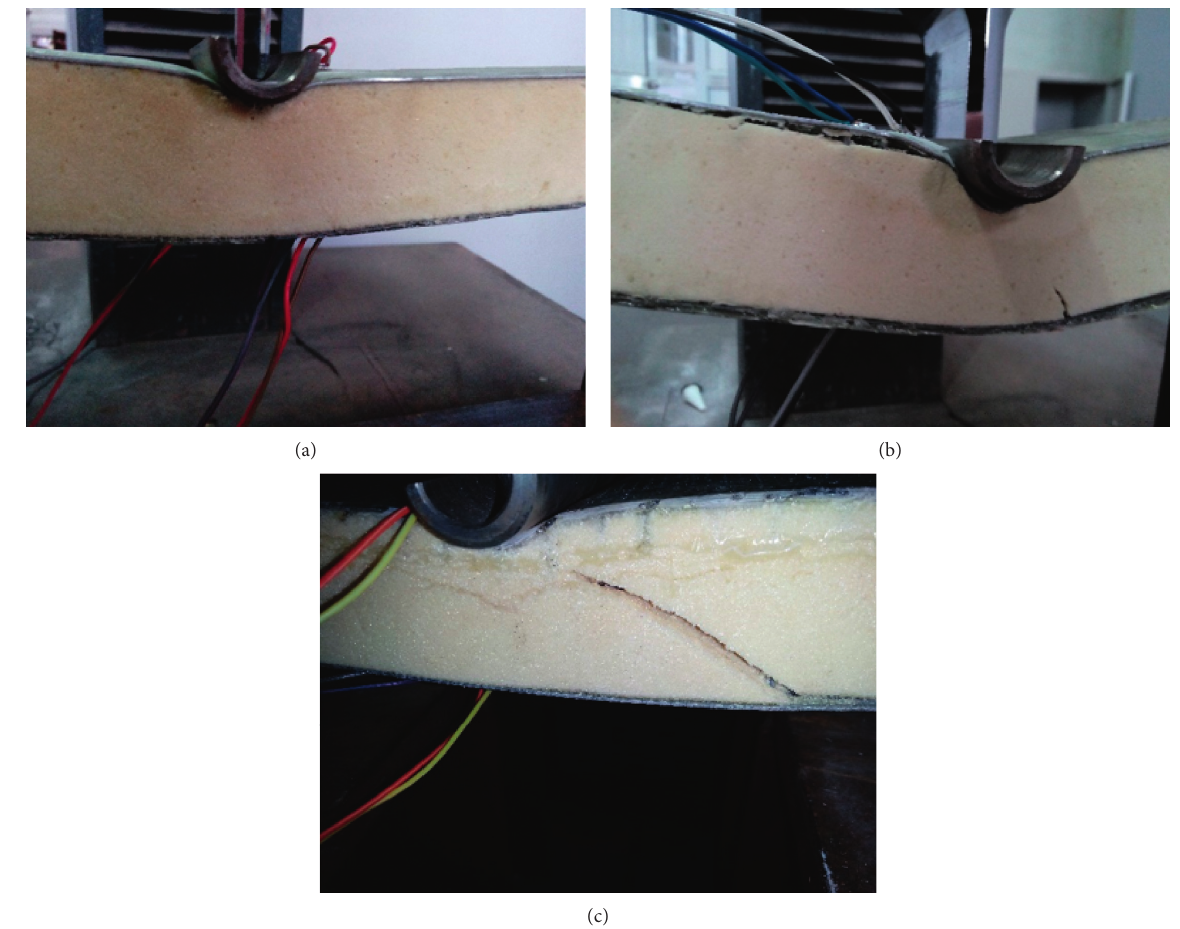
Figure 6: The failure modes of TFS beams: (a) core indentation failure of hybrid sandwich beams with foam core density of 35kg/m 3 , (b) core indentation failure of hybrid sandwich beams with foam core density of 80kg/m 3 , and (c) core shear failure of hybrid sandwich beams with foam core density of 150kg/m 3 under the span of 300mm and